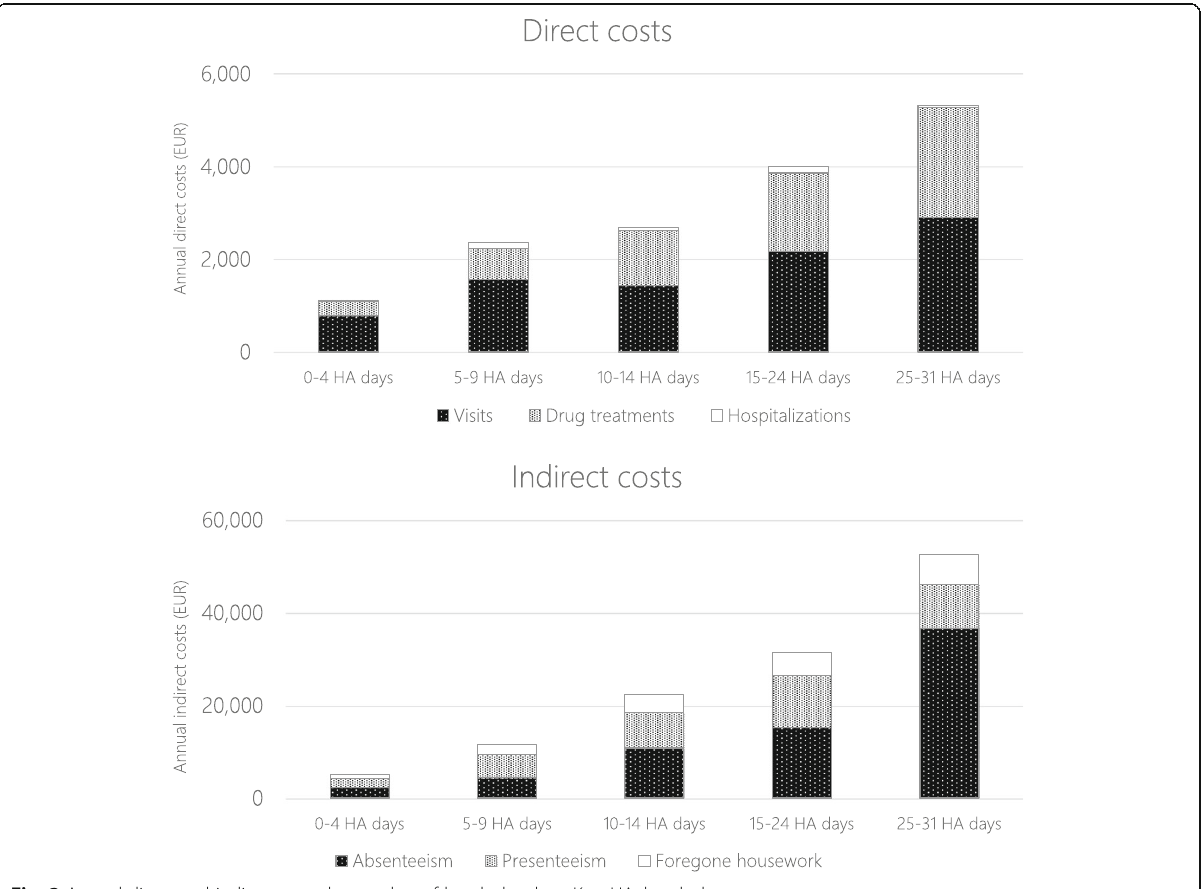
Fig. 3 Annual direct and indirect costs by number of headache days. Key: HA, headache